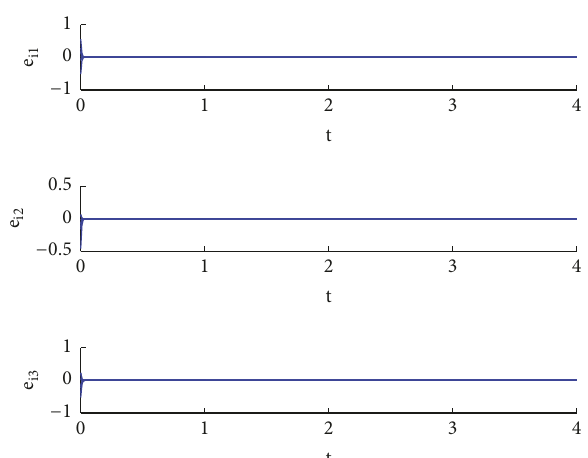
Figure 7: Evolution of feedback gains 𝑑 𝑖 (𝑡) with 𝑘 𝑖 = 10, 𝑖 = 1, 2, .. ., 10.